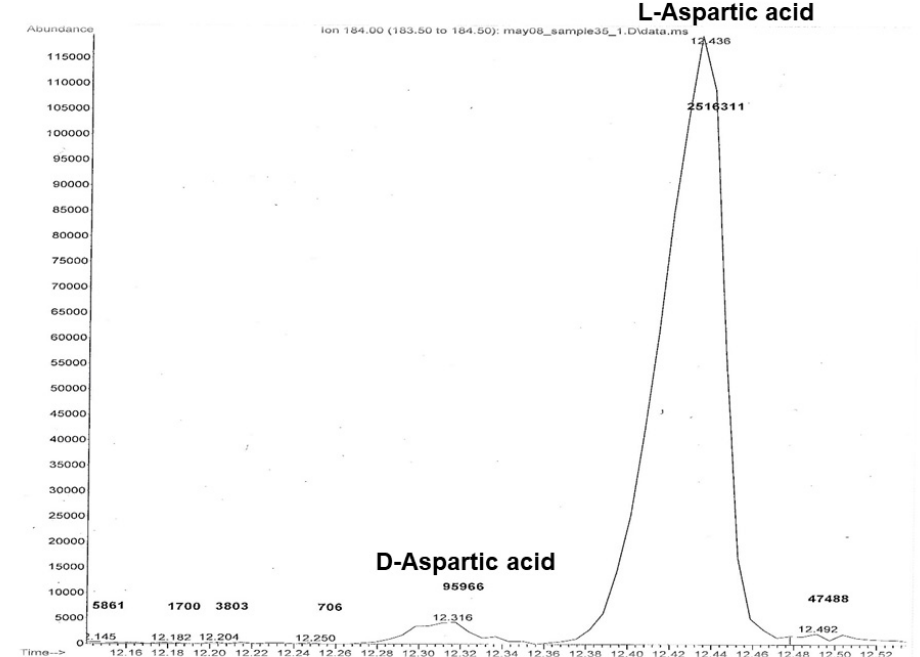
Figure 1. Aspartic acid chromatogram. It shows isomer forms D and L. The x -axis represents the retention time; the y -axis represents the abundance of the compounds.